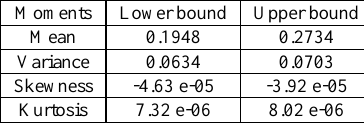
Table 7. Expected range of different moments for the optimal portfolio predicted by the model